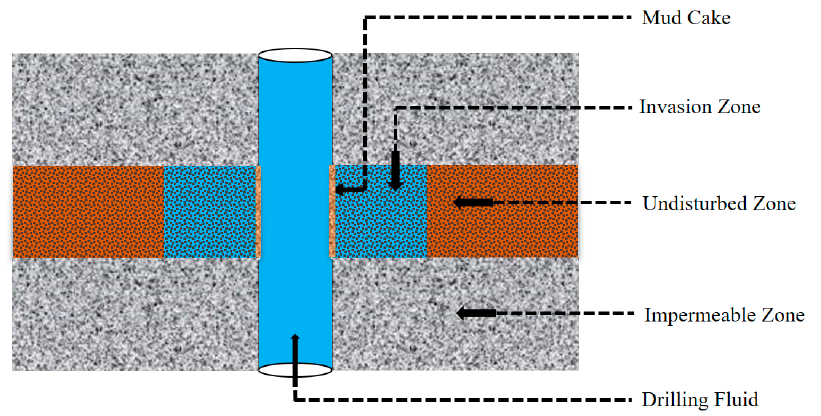
Figure 1. Schematic diagram of mud invasion process.